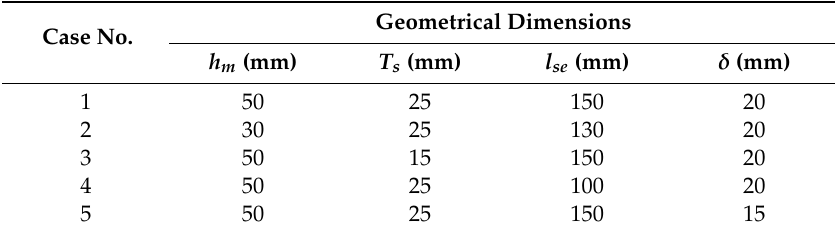
Table 2. Cases with di ff erent parameters { h m , T s , l se , δ